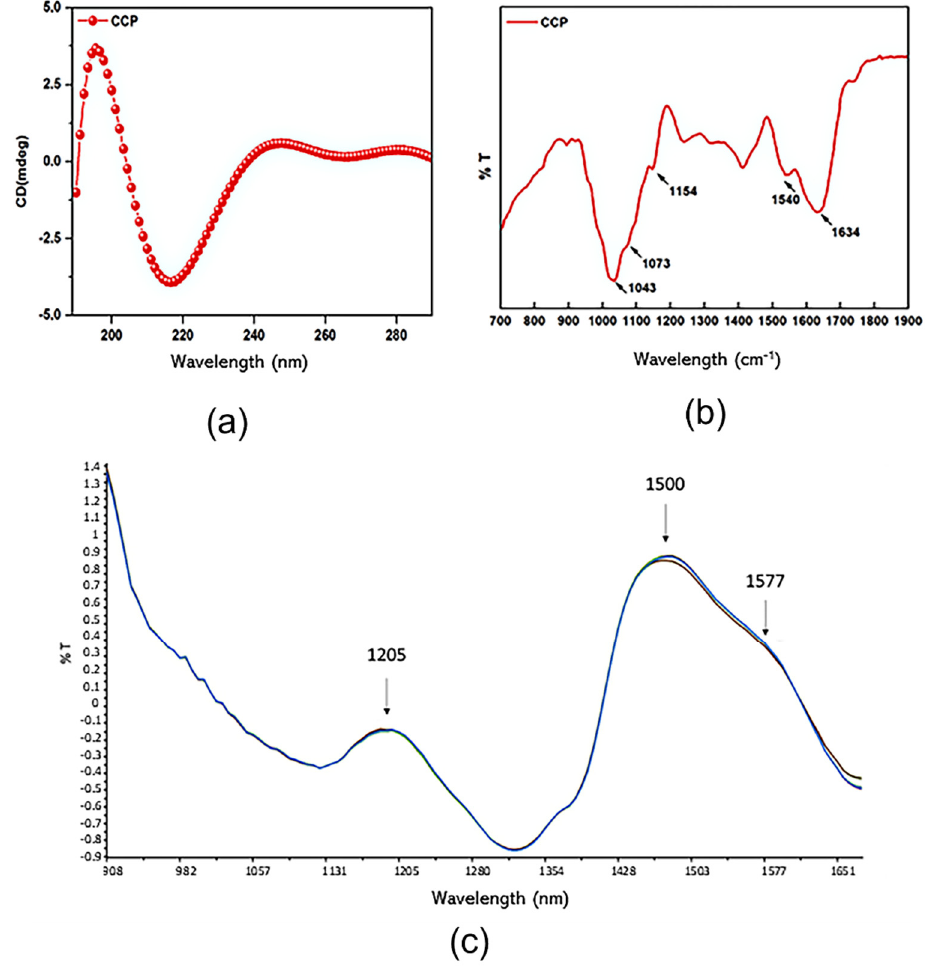
Figure 4. CCP structural organization. ( a ) CD spectra, ( b ) FT-IR spectrum with a characteristic β -turns/random coil conformation in the Amide I and Amide II regions at 1634 cm − 1 and 1540 cm − 1 , respectively, and typical polysaccharides vibrations in the region 800–1200 cm − 1 . ( c ) NIR spectrum showing the fundamental absorption peaks of phenolic compounds and unsaturated fatty acids in cis conformation (1205, 1500, and 1577 nm).